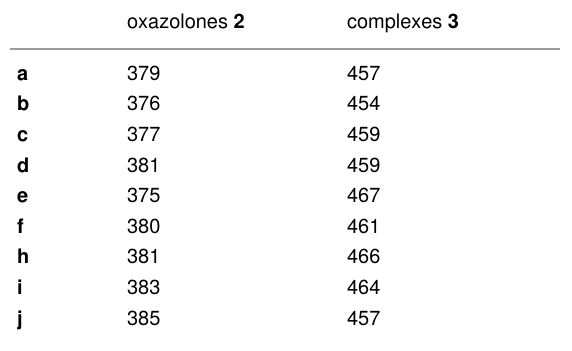
Table 1: UV–vis spectra of 2 and 3 : absorption maxima ( λ max ,